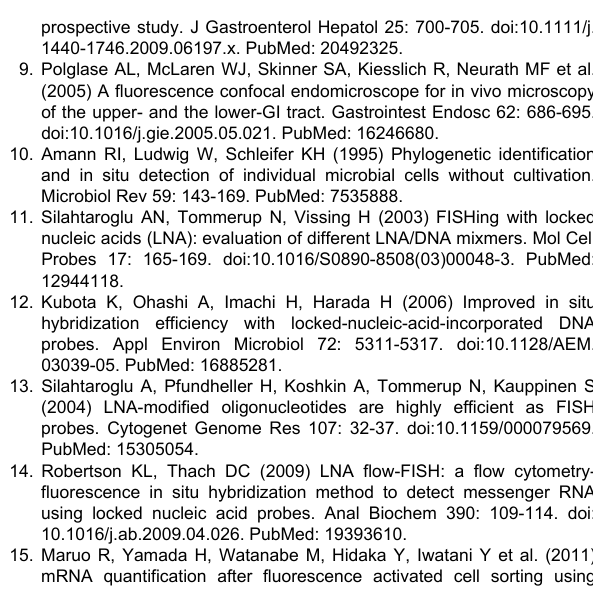
Figure S1. Fluorescence intensity results of Helicobacter strains (non 26695 (ATCC 700392)) tested in this study. The results represent the positive signal of each sample after the subtraction of the respective